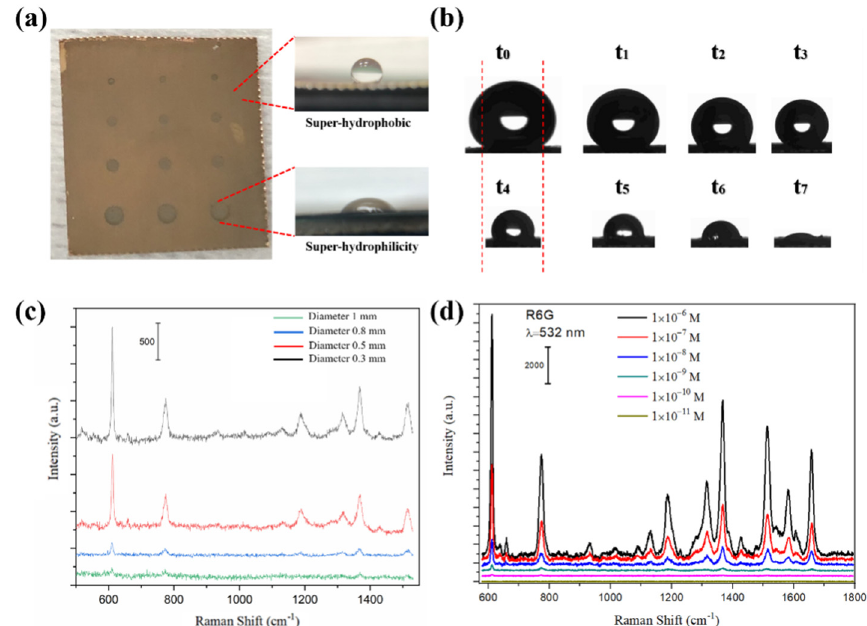
Figure 4. ( a ) Photographs of HWS, where the dark grey area showed hydrophilic properties with a contact angle of 21 ± 2° and the brown area showed hydrophobic properties with a contact angle of 151 ± 3°. ( b ) The evaporating evolution process of a 20 μ L droplet containing 10 − 7 M R6G under room temperature. ( c ) The dependence of SERS signals intensities on the size of the SERS active area. ( d ) SERS spectra of different concentrations of R6G (1 × 10 − 6 to 1 × 10 − 11 M) on HWS.